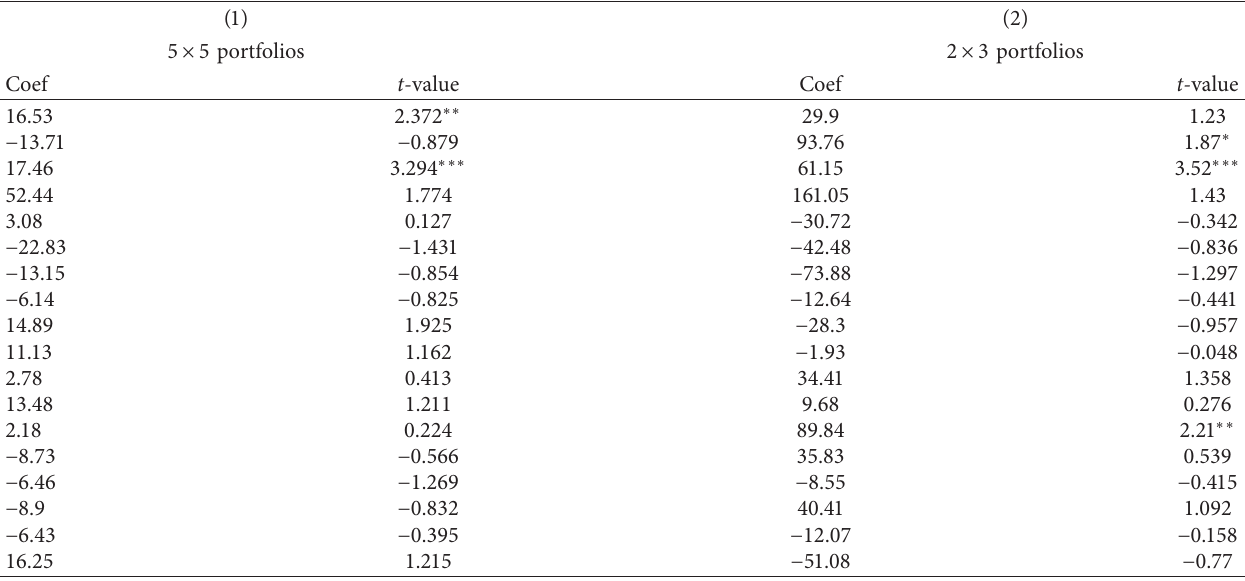
Table 9: Testing SDF loadings of g t controlling all benchmark factors. This table reports testing results of SDF loading estimates controlling all 99 benchmark factors simultaneously. The sample period is from July 2000 to December 2019. In column 1, we use previous 650 5 × 5 bivariate sorted portfolios as test assets, while, in column 2, we use 156 2 × 3 bivariate sorted portfolios. (1) (2)